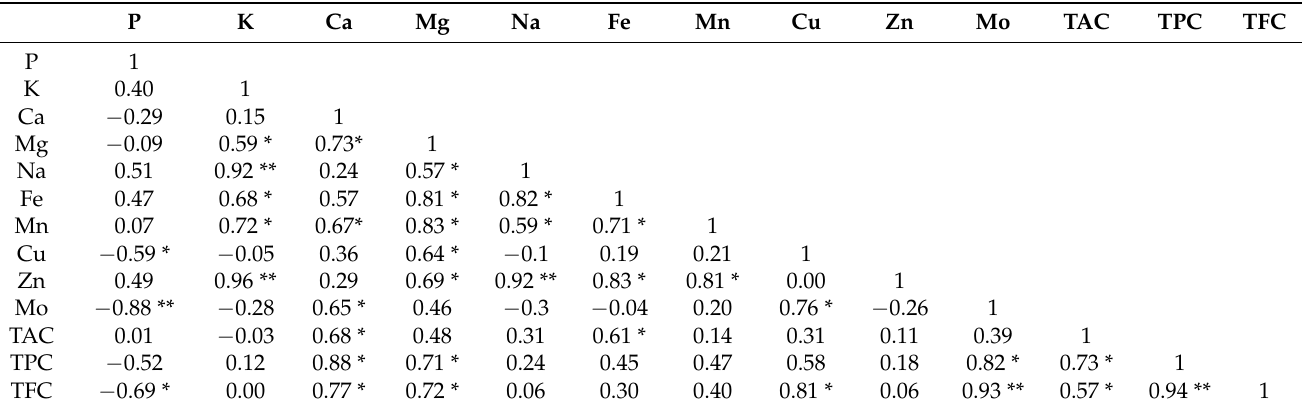
Table 7. Correlation analysis between TPC, TAC, TFC and phosphorus (P), potassium (K), calcium (Ca), magnesium (Mg), natrium (Na), iron (Fe), manganese (Mn), copper (Cu), zinc (Zn) and molybdenum (Mo) of six edible flowers grown for two years.